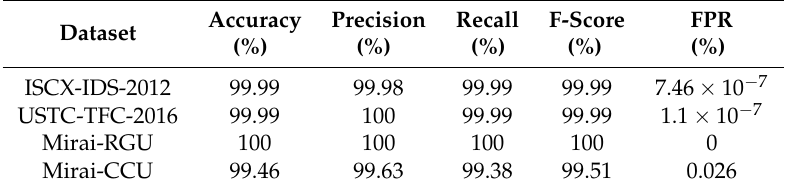
Performance evaluation results of the proposed solution on the four datasets with 10-fold testing.